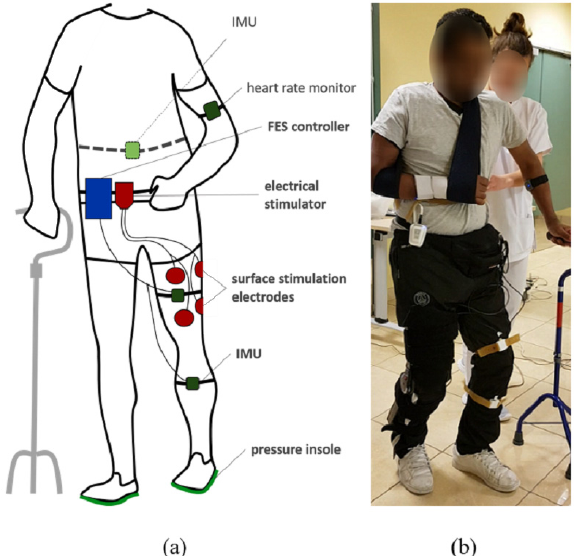
Figure 1. Experimental setup diagram ( a ) and associated picture ( b ). The participants are equipped with pressure insoles and two IMUs on the leg. A controller records and processes data to adapt online FES of quadriceps and hamstrings depending on knee angle and gait events. A wireless IMU in the back and a heart rate sensor are additionally used to evaluate motion and performances.